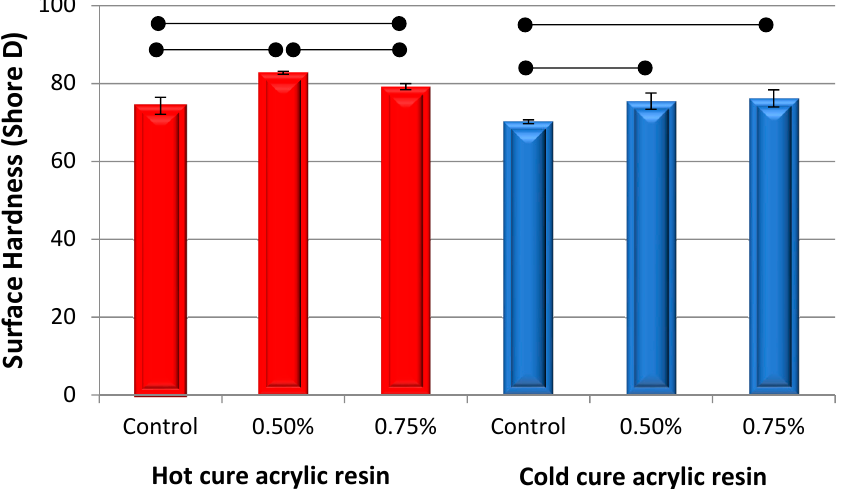
Figure 10. Bar chart showing the differences between the mean surface hardness values in the HC and CC acrylic resins incorporated with Ag-Zn zeolite at different concentrations (0.50 wt.% and 0.75 wt.%) and without any Ag-Zn zeolite (control group). Horizontal lines connecting two bars indicate statistical significance ( p < 0.05).